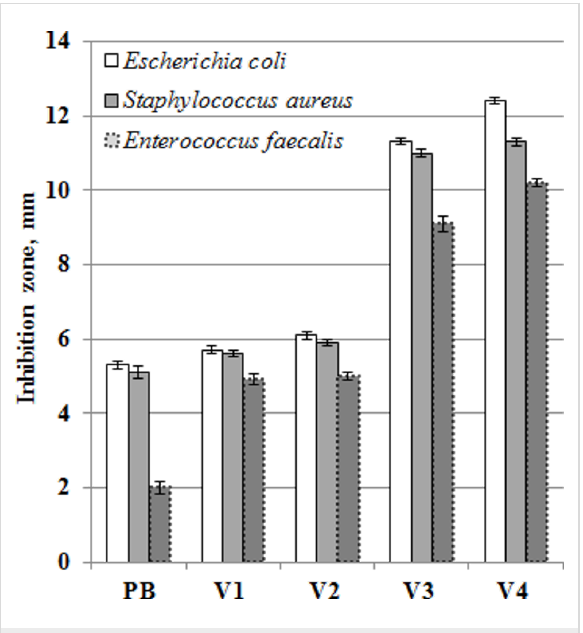
Figure 9: Antibacterial activity of the